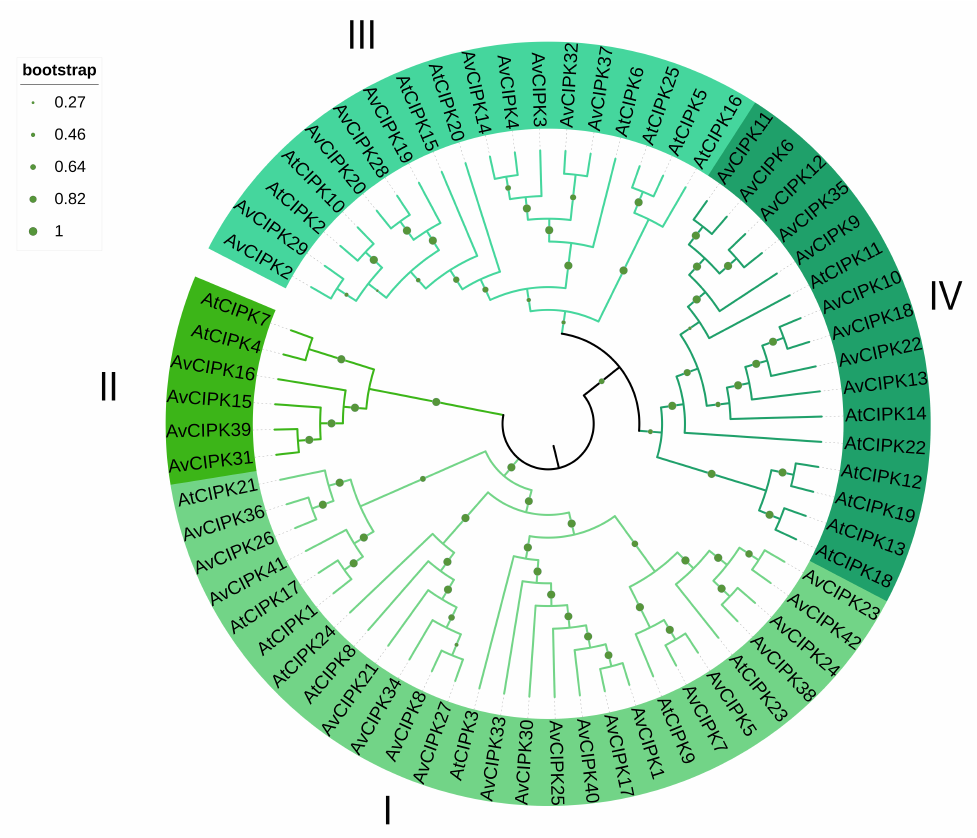
Figure 1. The phylogenetic analysis of the AtCIPK and AvCIPK proteins. Each clade in the phyloge- netic tree is represented by a different color. I–IV represent the different